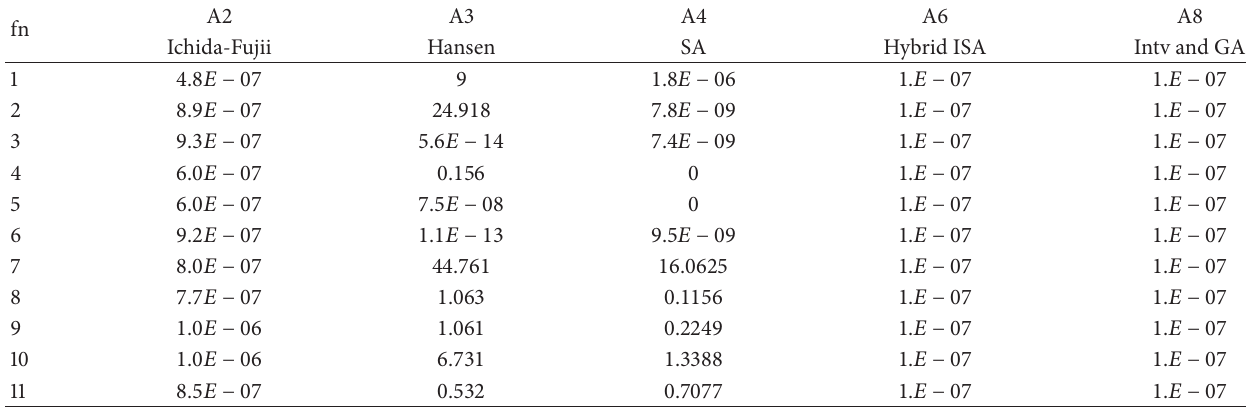
Table 3: The value of 𝑓𝑏𝑒𝑠𝑡 from A2, A3, A4, A6, and A8 for 𝑛 = 10 .